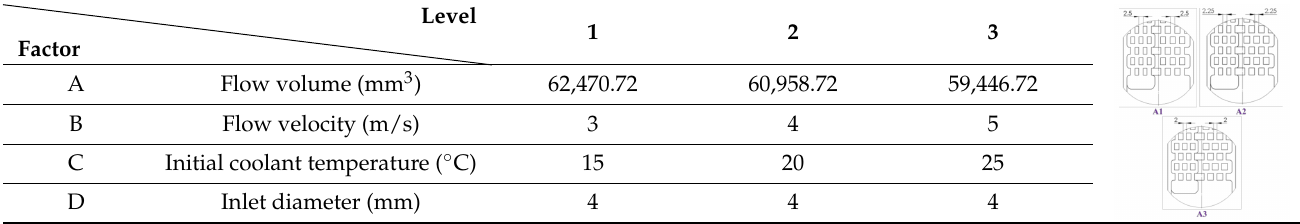
Table 3. L9 (3 4 ) factor level table.